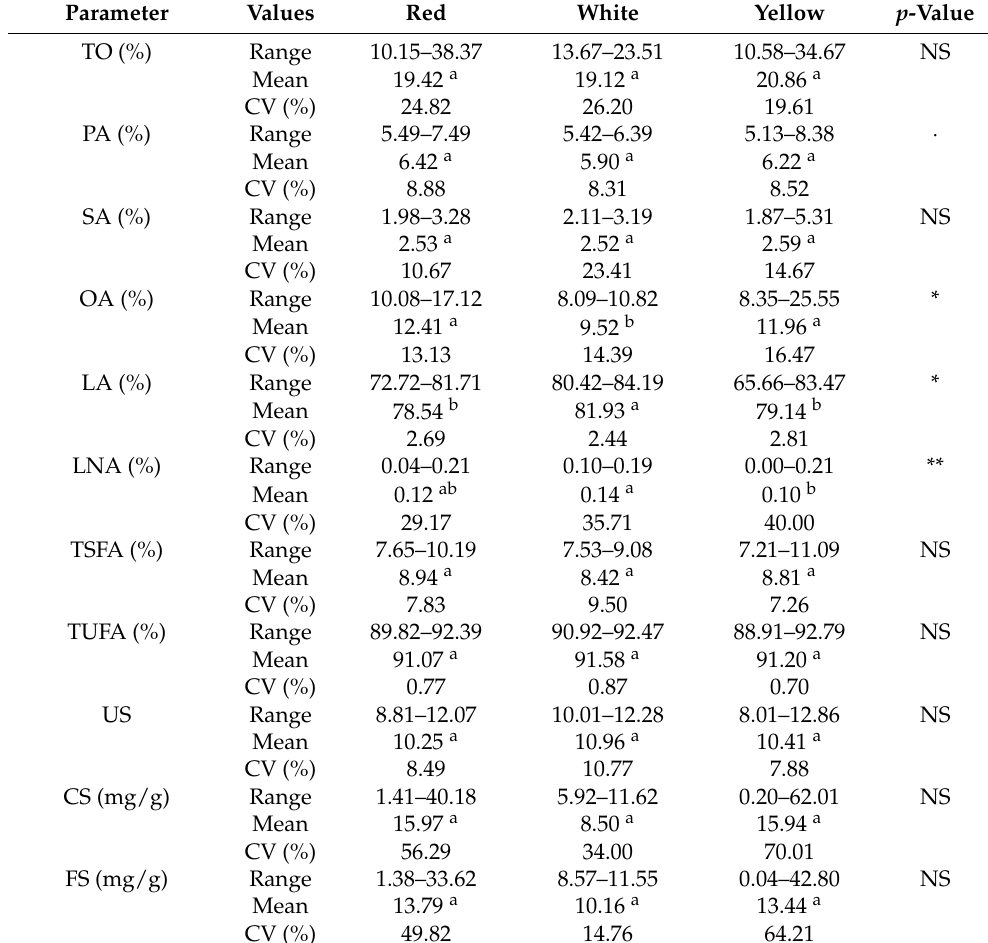
Table 2. Variations in total oil content, fatty acid profile, phytochemical contents, and antioxidant activities according to flower